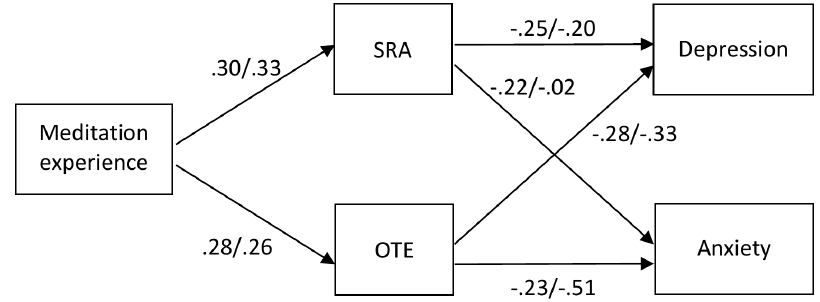
Figure 1. Multigroup path model on the effects of meditation experience on mindfulness and on depression and anxiety. Numbers are standardized path coefficients (left: German sample; right: Spanish sample). SRA = Self-regulated Attention; OTE = Orientation to Experience. Self-regulated Attention and Orientation to experience were allowed to correlate, as were depression and anxiety. All p s , .002, except for the path of SRA to anxiety in the Spanish sample, p =.786.